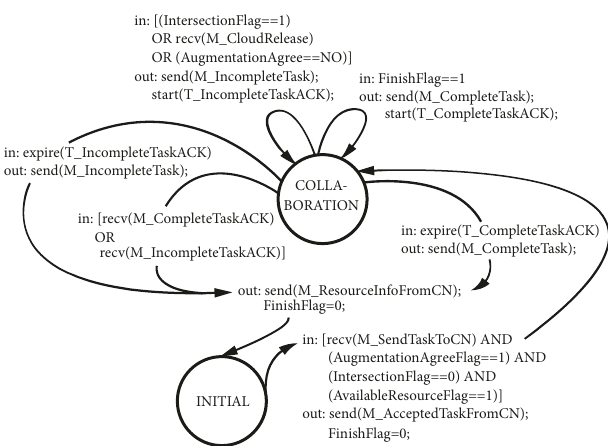
Figure 9: Transition from INITIAL to COLLABORATION state.